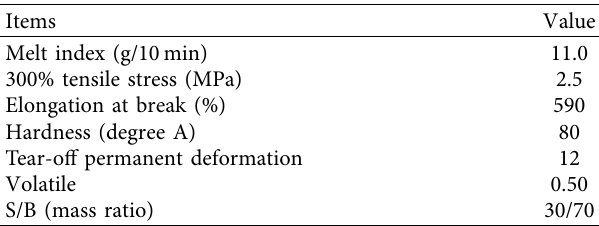
Table 4: The performance indicators of SBS